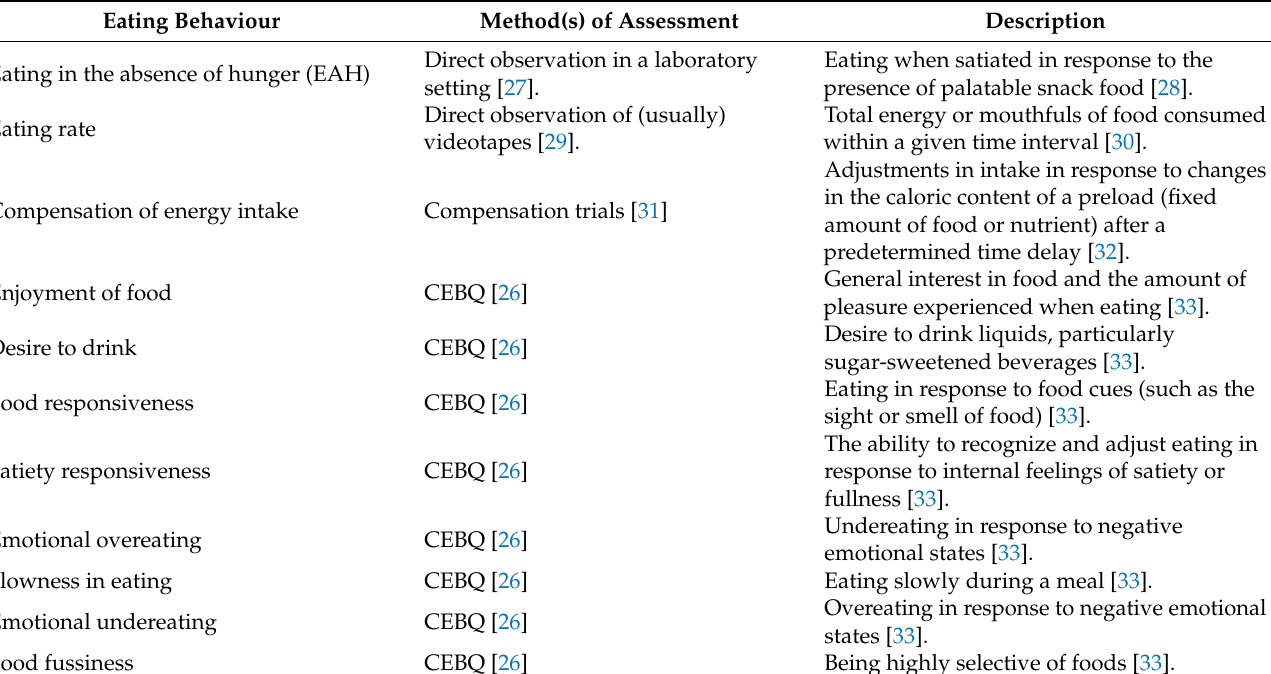
Table 1. Different methods and measures to assess eating behaviour in